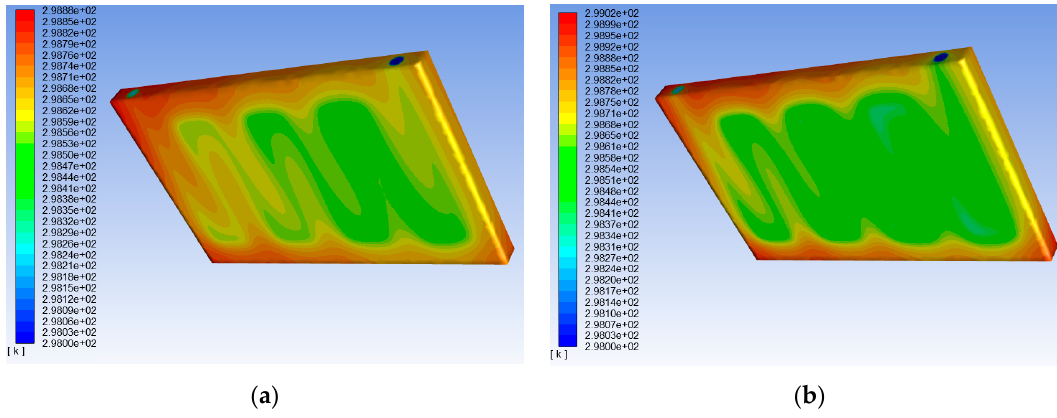
Figure 12. The temperature profile for different plate material: ( a ) copper and ( b ) aluminum.